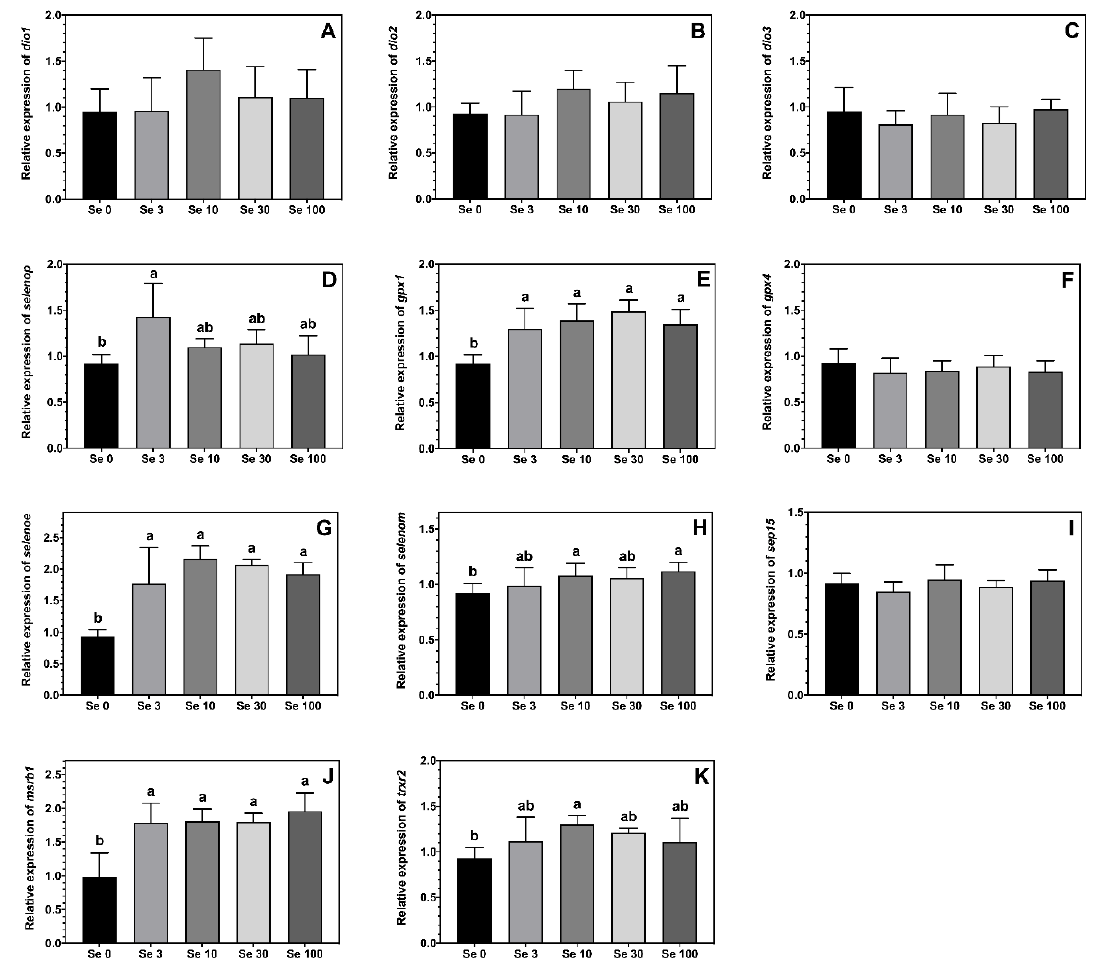
Figure 2. Expression levels (means ± SD, n = 6) of selenoproteins iodothyronine deiodinase 1, dio1 ( A ); iodothyronine deiodinase 2, dio2 ( B ); iodothyronine deiodinase 3, dio3 ( C ); selenoprotein p, selenop ( D ); glutathione peroxidase 1, gpx1 ( E ); glutathione peroxidase 4, gpx4 ( F ); selenoprotein E, selenoe ( G ); selenoprotein M, selenom ( H ); 15-kda selenoprotein, sep15 ( I ); methionine sulfoxide reductase 1, msrb1 ( J ) and thioredoxin reductase 2, trxr2 ( K ) measured by real-time PCR. Data were normalized to a geometric mean of ef1a and bactin and are presented as fold-changes of mRNA abundance compared with Se0. One-way ANOVA on ranks followed by Tukey’s HSD postdoc test was used to detect significant differences as displayed through uncommon superscript letters.